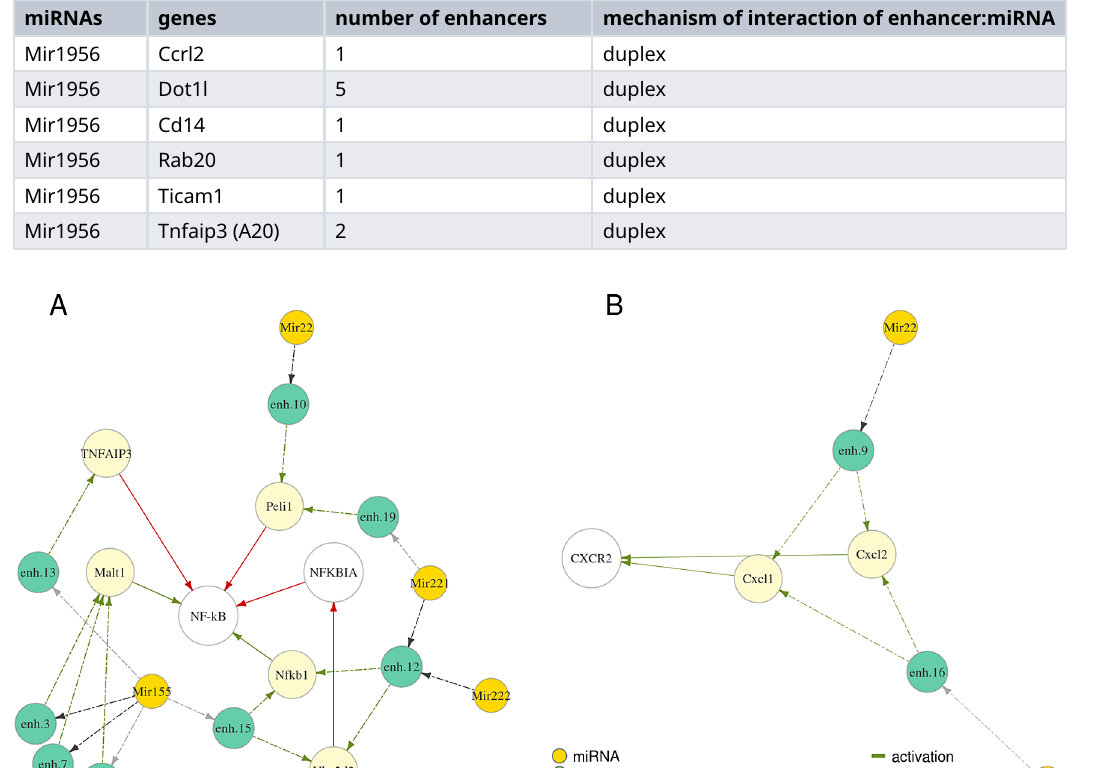
Table 2. The most promising miRNAs predicted for M2 pre-stimulated infected BMDMs to upregulate genes via enhancer activation.